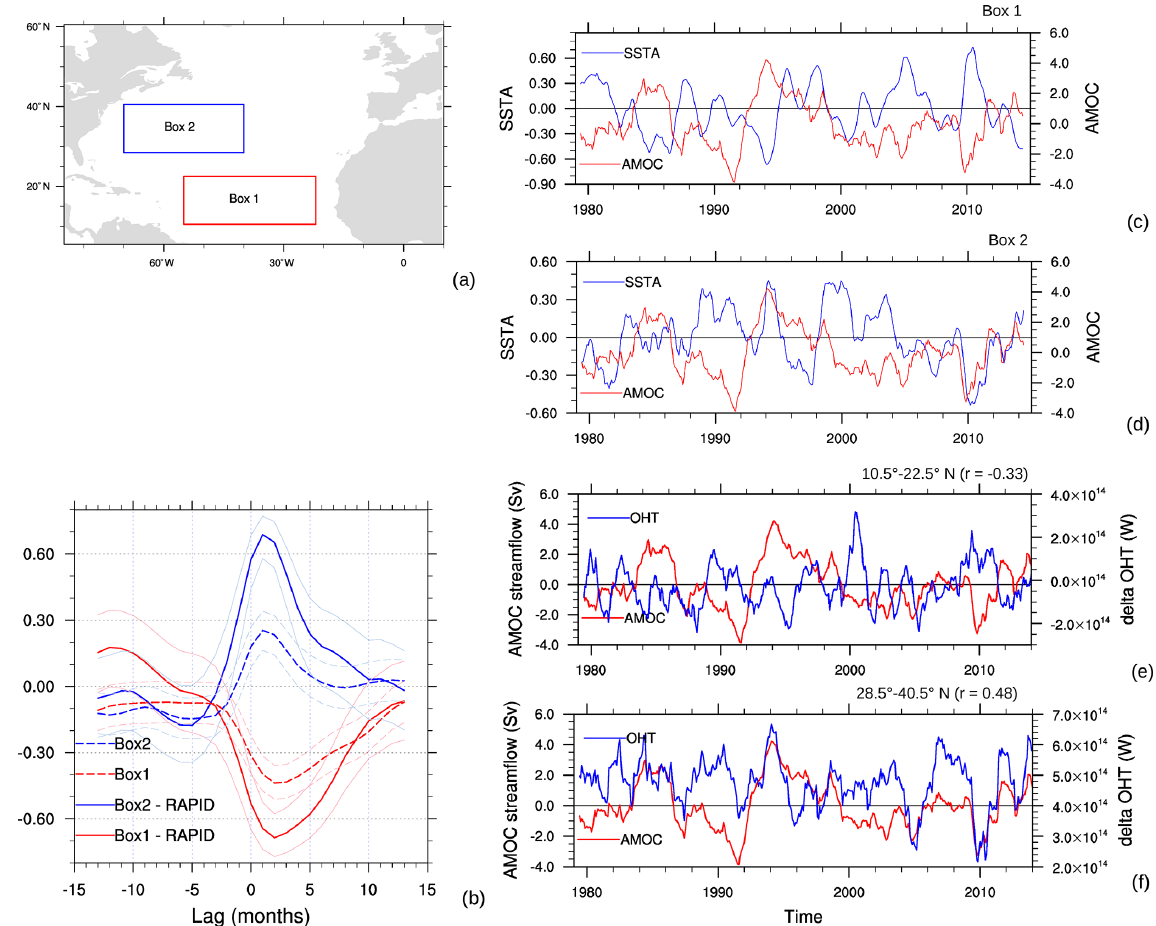
Figure 4. Relationship of the AMOC at 26 ◦ N, SSTAs and δ OHT over two regions in the North Atlantic in the assimilation experiment: (a) regions used for averaging SST; (b) lagged correlations between the AMOC and SSTAs over Box 1 (red lines) and Box 2 (blue lines). Solid lines correspond to the RAPID period and dashed lines to 1979–2014, and light colours show the significance at 95%; time series for the AMOC and SSTAs averaged (c) for Box 1 and (d) for Box 2, both smoothed with a 12-month running mean; time series for the AMOC and δ OHT w.r.t. (e) 10.5–22.5 ◦ N and (f) 28.5–40.5 ◦